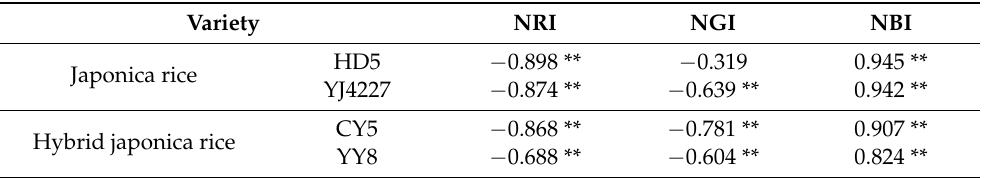
Table 10. Correlation coefficients between the color indices of rice leaves and the nitrogen contents of the whole plants after anthesis. Variety